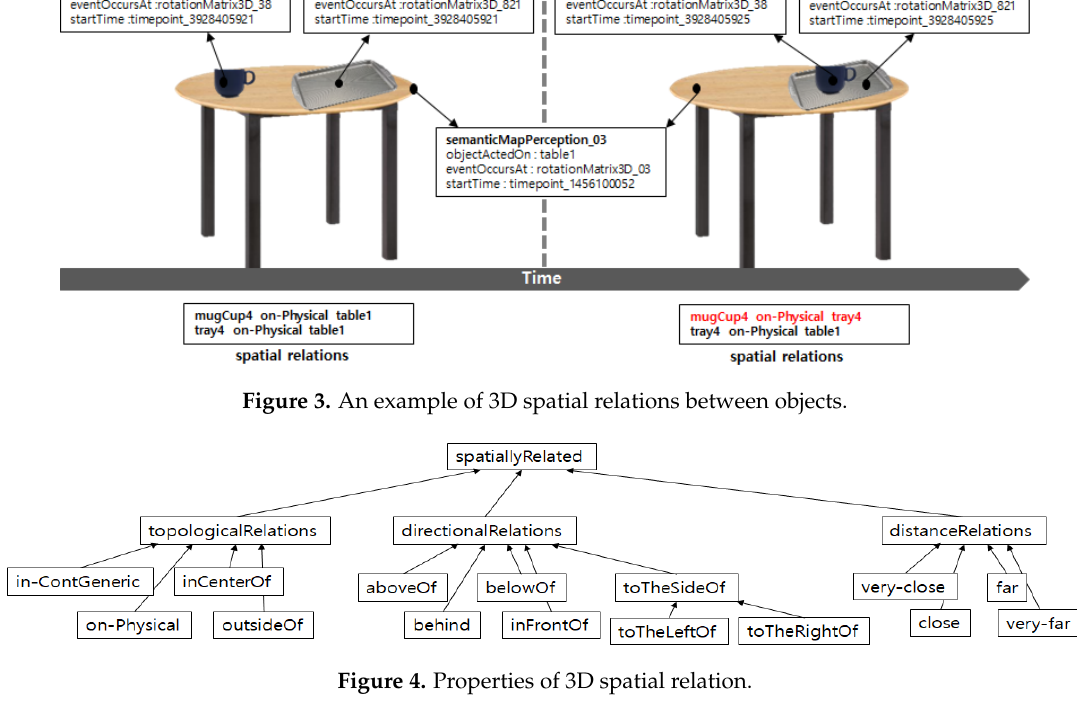
Figure 4. Properties of 3D spatial relation.